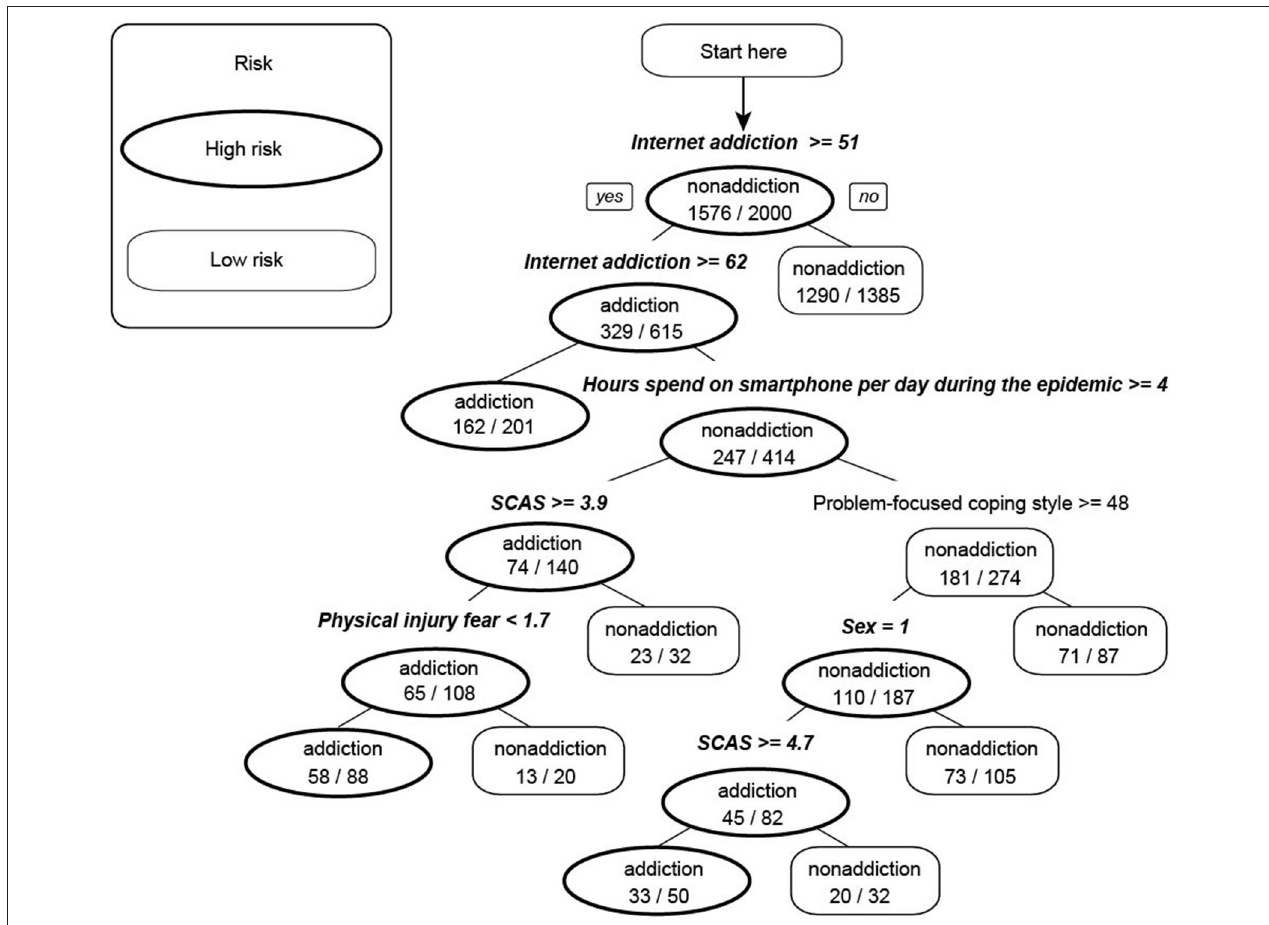
FIGURE 3 | Decision tree for detecting smartphone addiction among children and adolescents. Anxiety symptoms mean the total scores of Spence Child Anxiety Scale. The assignment values of these classified variables were: sex, 1 = female; 2 = male; hours spend on smartphone per day during the epidemic, 1( ≤ 1h) − 4 ( ≥ 5h). Factors with significant meaning have been written in bold italic